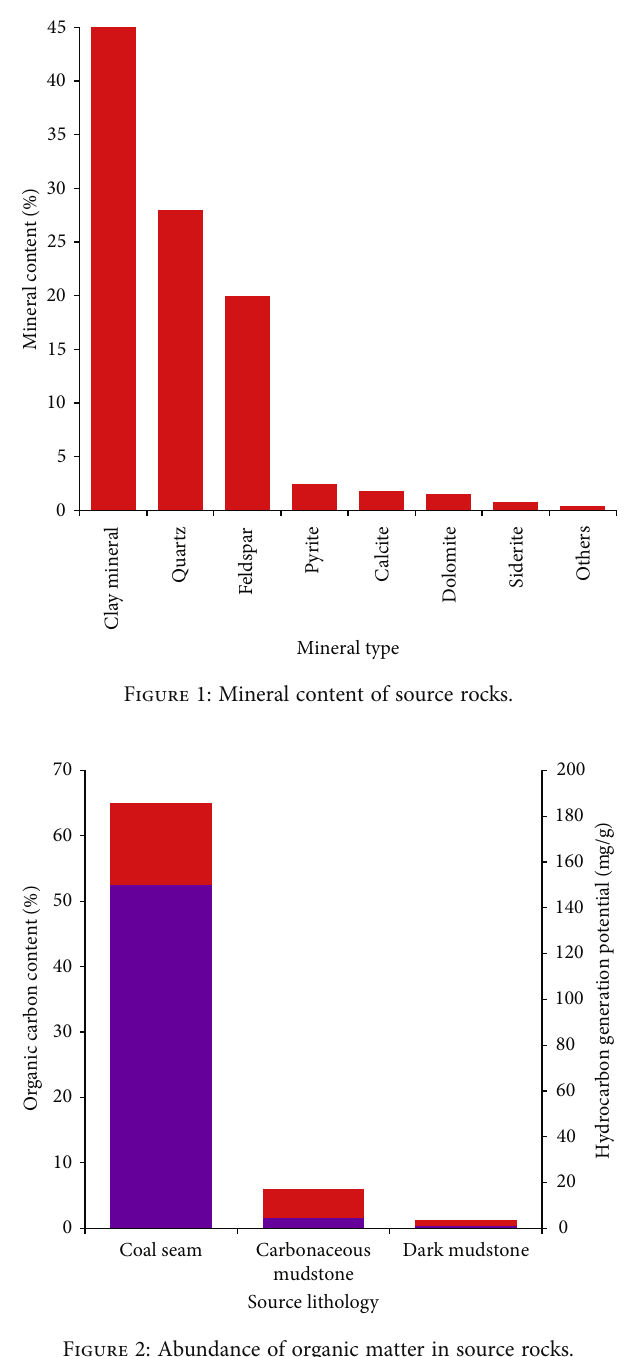
Figure 2: Abundance of organic matter in source